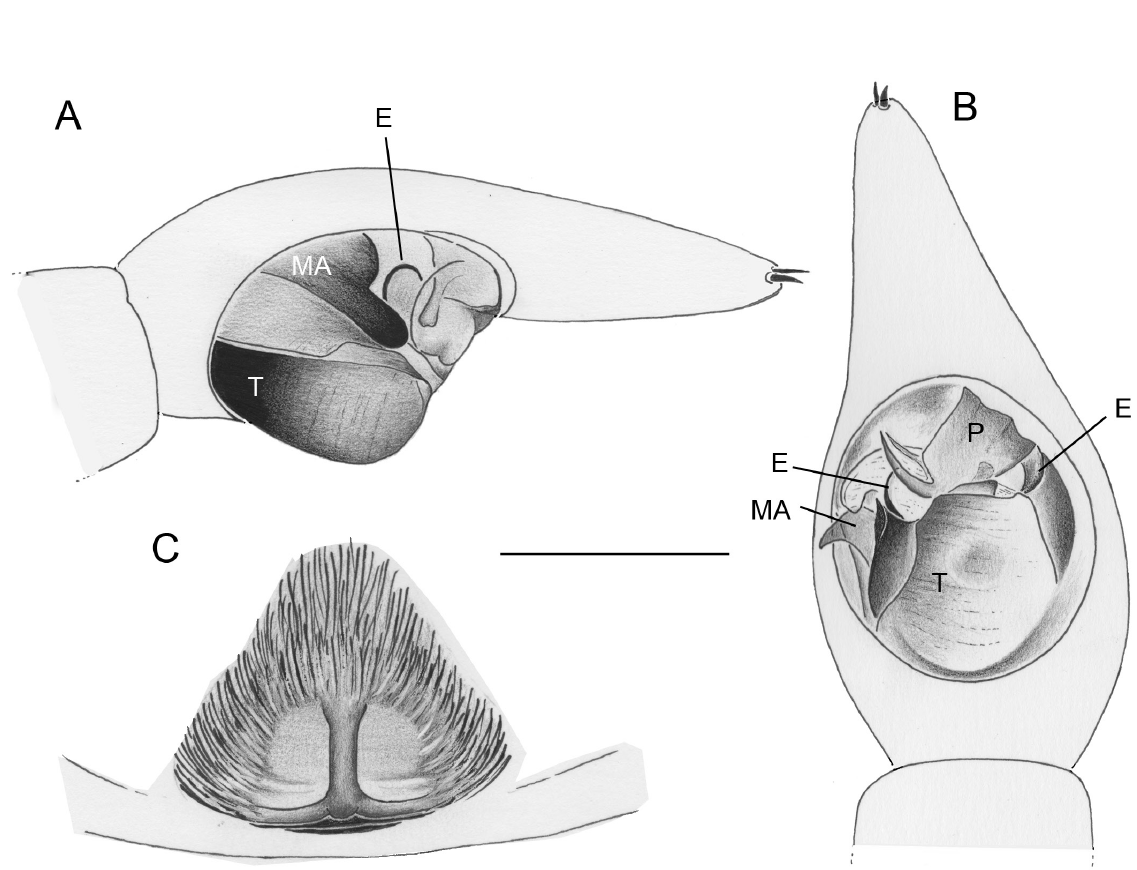
Fig. 7. Ocyale ghost Jocque M. & Jocqué R. sp. nov. A–B . Palp (holotype, ♂). A . Retrolateral view. B . Ventral view. C . Epigyne (paratype, ♀, MRAC 245338), ventral view. Scale bar = 1mm. Abbreviations: MA = median apophysis; P = palea; T = tegulum; * =